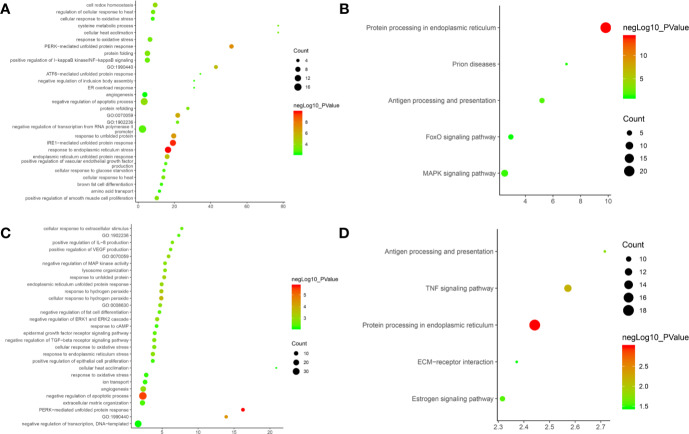
Bubble chart. (A) biological processes of Olibanum-treated MD-MB 231 cells; (B) signaling pathways of Olibanum-treated MD-MB 231 cells; (C) biological processes of β-boswellic acid -treated MD-MB 231 cells; (D) signaling pathways of β-boswellic acid -treated MD-MB 231 cells.